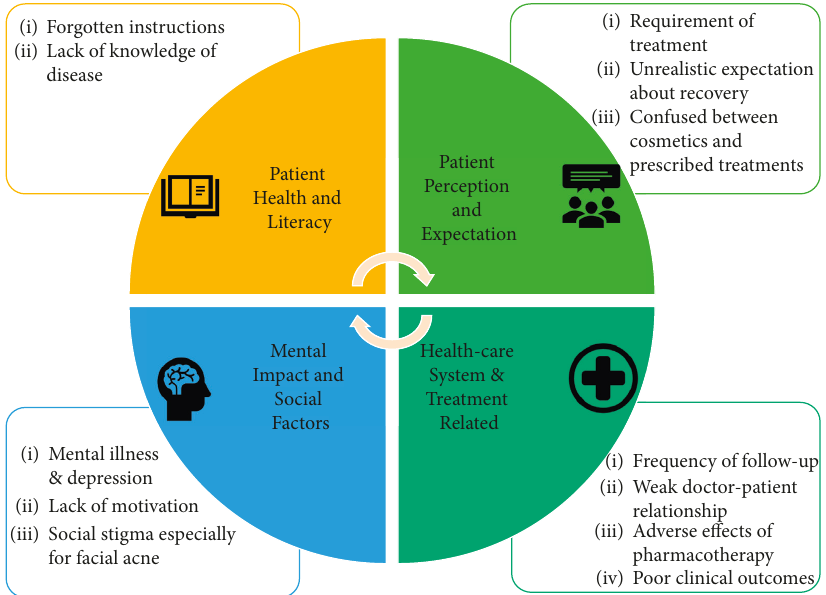
Figure 1: Factors associated with poor